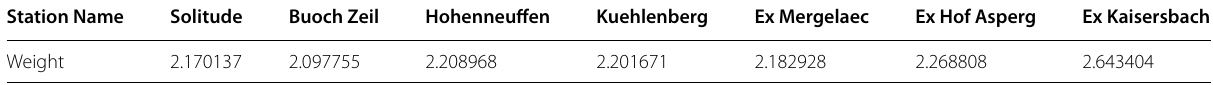
Table 3 Point-wise weights